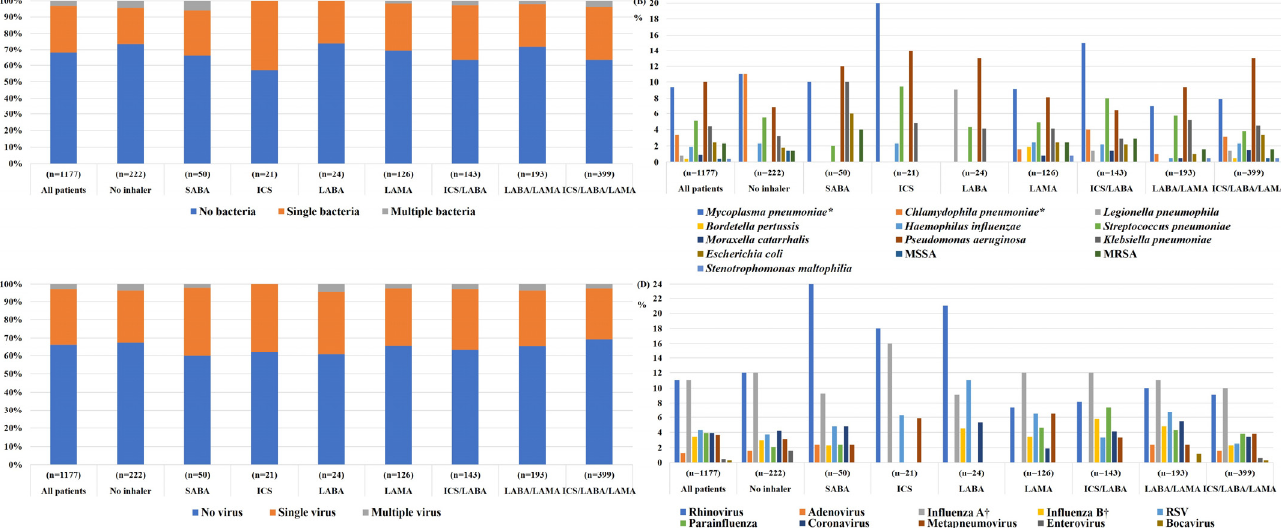
Figure 1. Bacterial and viral detection rates during acute exacerbations of chronic obstructive pulmonary disease according to the drug used: ( A ) overall bacterial detection rate, ( B ) detection rate for each bacterial species, ( C ) overall virus detection rate, and ( D ) detection rate for each virus species. Values are presented as percentages. SABA, short-acting beta-agonist; ICS, inhaled corticosteroid; LABA, long-acting beta 2-agonist; LAMA, long-acting muscarinic antagonist. * Bacteria were detected in respiratory specimens via polymerase chain reaction, or in serum via immunoglobulin M measurement (n = 739). † Viruses were detected in respiratory specimen using immunofluorescence assay or polymerase chain reaction (n = 1131). MSSA, methicillin-sensitive Staphylococcus aureus ; MRSA, methicillin-resistant Staphylococcus aureus ; RSV, respiratory syncytial virus.